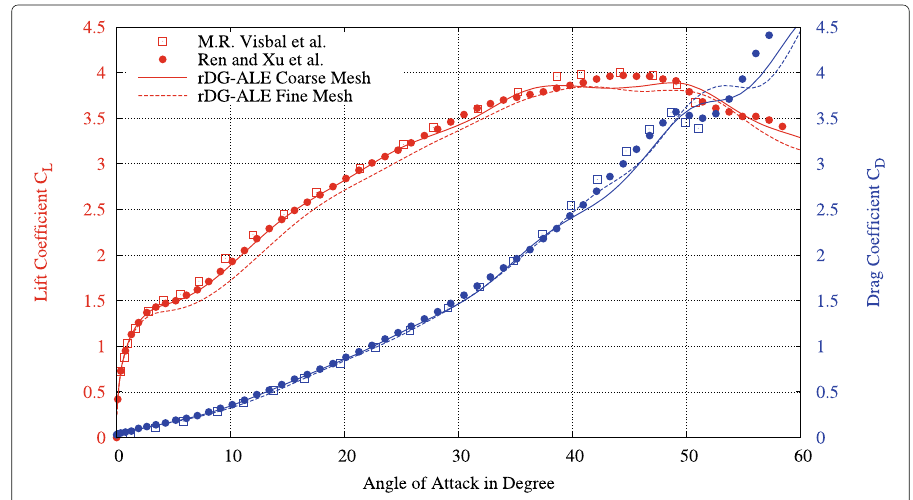
Fig. 14 Lift coefficients and drag coefficients versus angles of attack for the pitching NACA0015 case